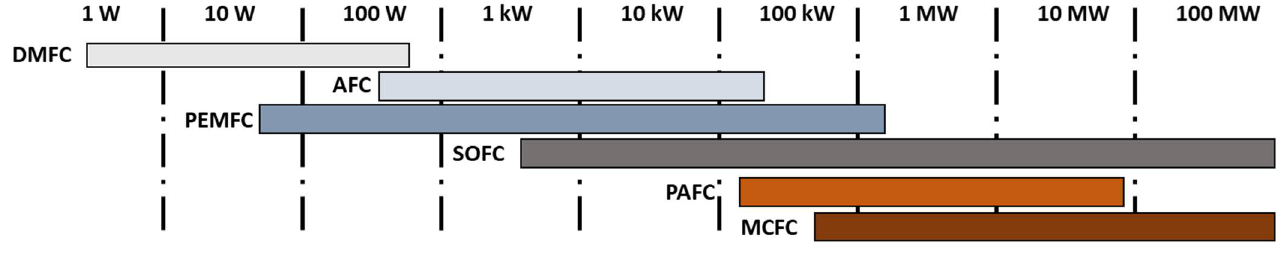
Figure 2. Fuel cell technology power application